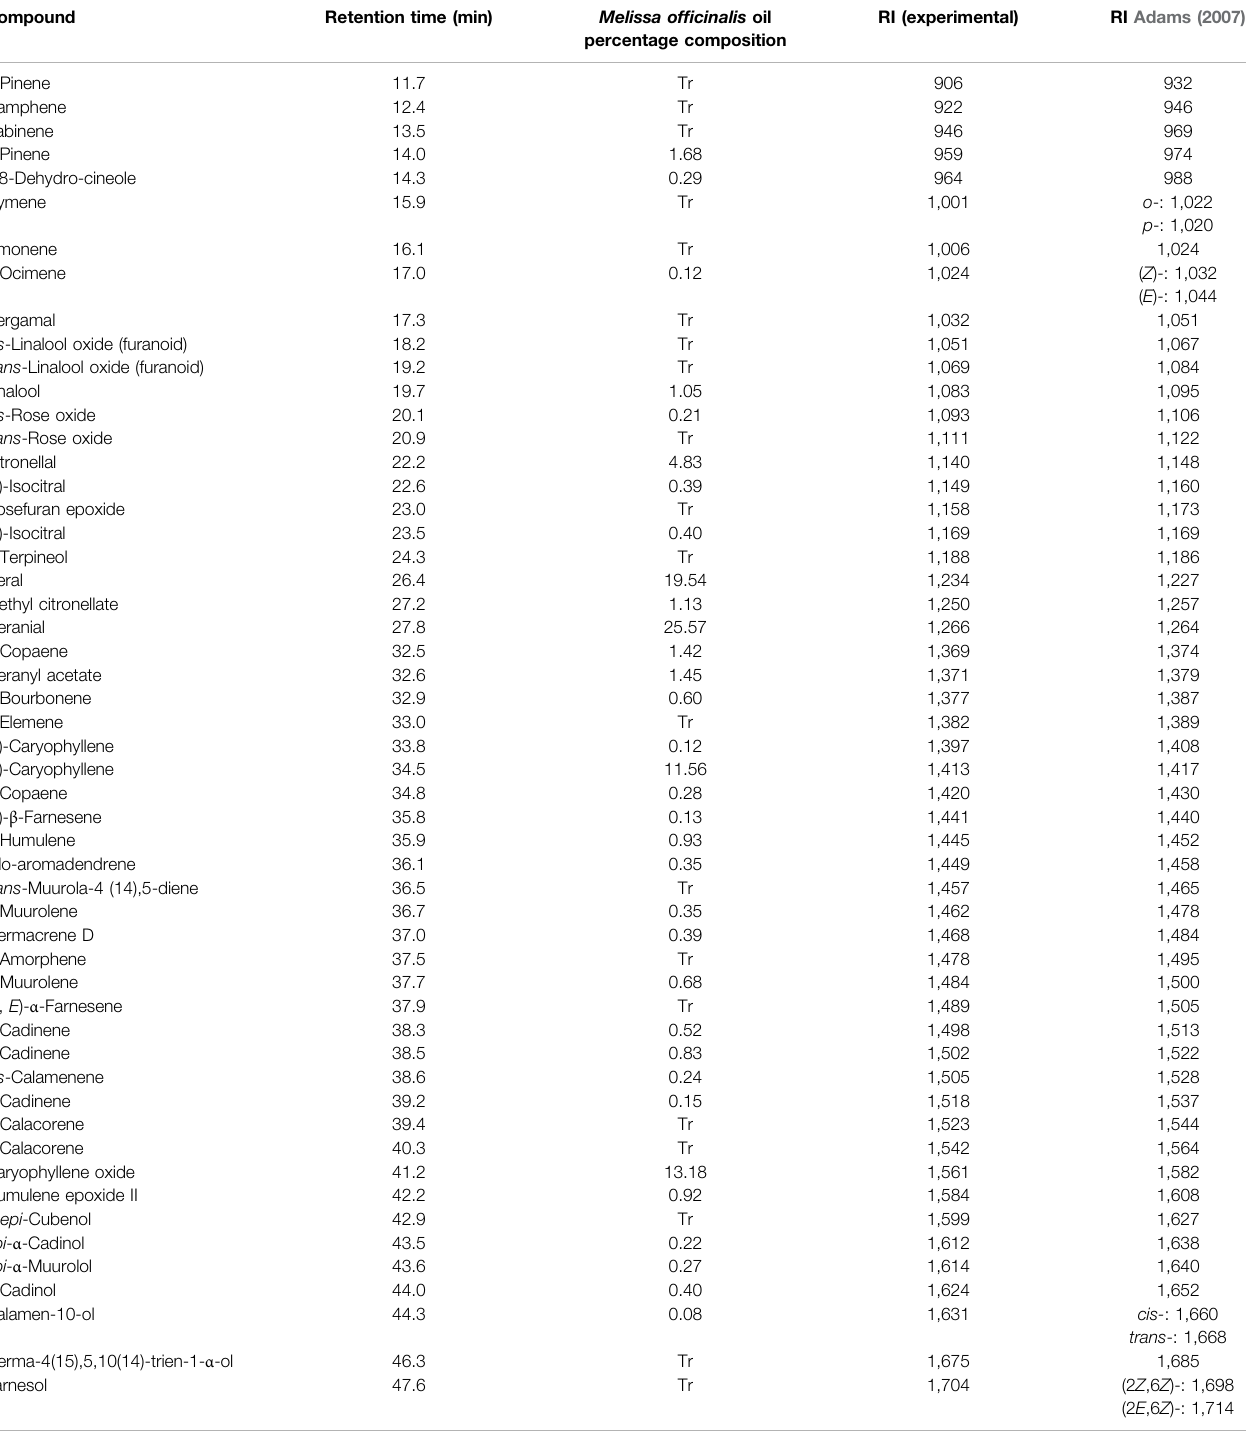
TABLE 1 | Percentage composition of assigned compounds detected in the Melissa of fi cinalis essential oil (based on all detected peaks), following GC-MS analysis. Compound Retention time (min) Melissa of fi cinalis oil RI (experimental) RI Adams (2007) percentage composition α -Pinene 11.7